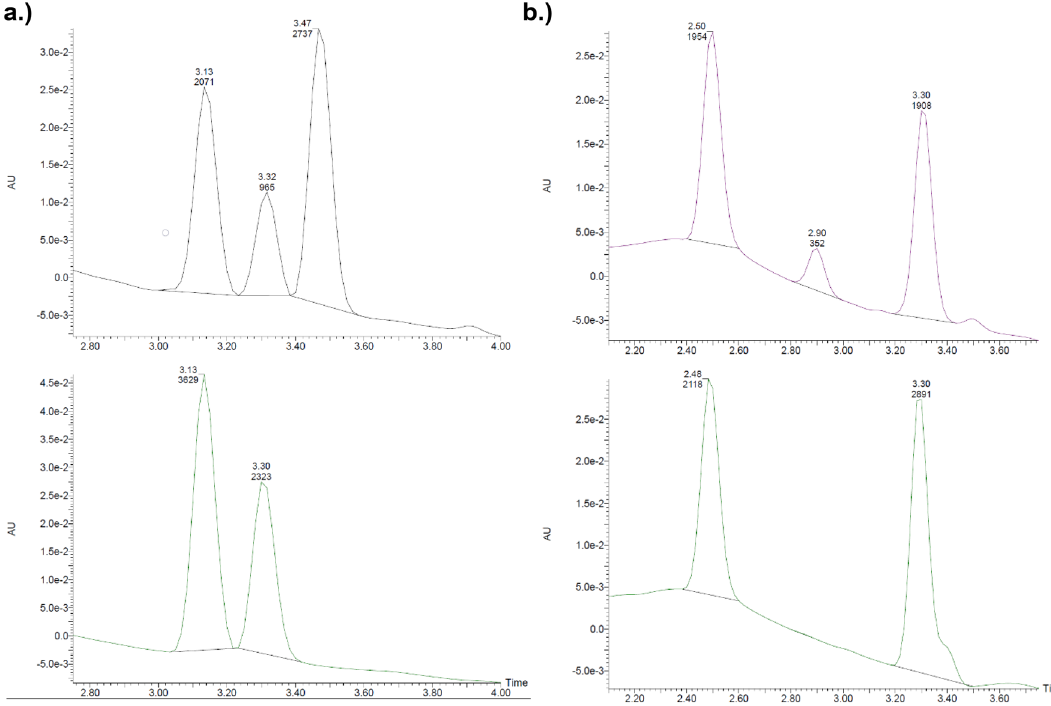
Figure 4. Chromatographic separation of thiamine (retention time = 3.3 min) (10 µM), ( a ) pyridoxine (retention time = 3.1 min, 100 µM) or ( b ) nicotinic acid (retention time = 2.5 min, 100 µM), with (bottom) 0 or (top) 0.33 µg/mL thiaminase for 2 h. The formation of the respective products of pyridoxine and nicotinic acid in the presence of thiaminase is observed at retention times of 3.5 min and 2.9 min,